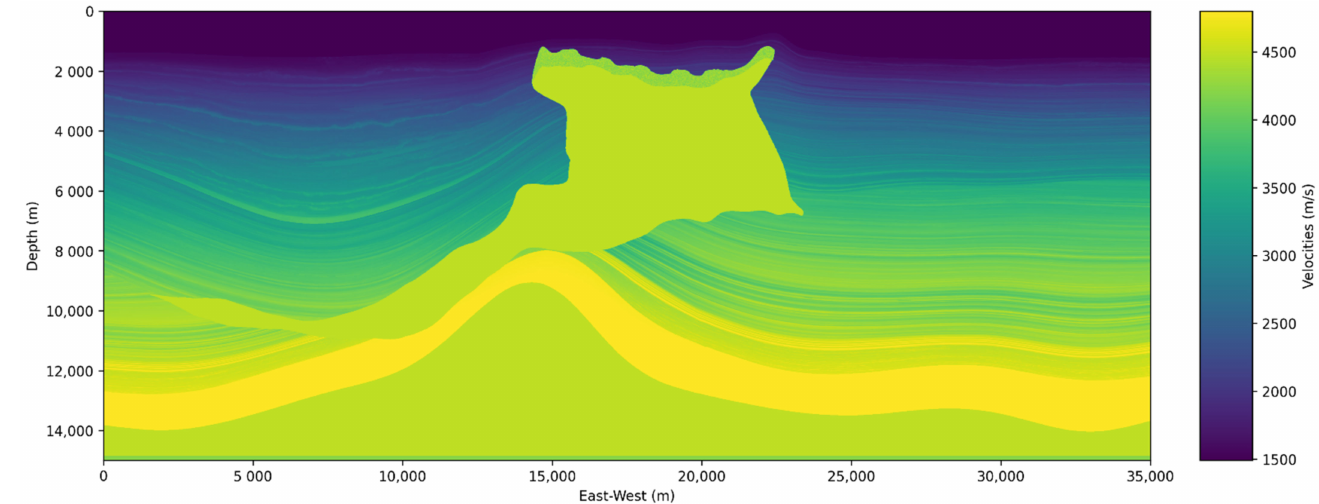
Figure 1. The velocity model cross section.